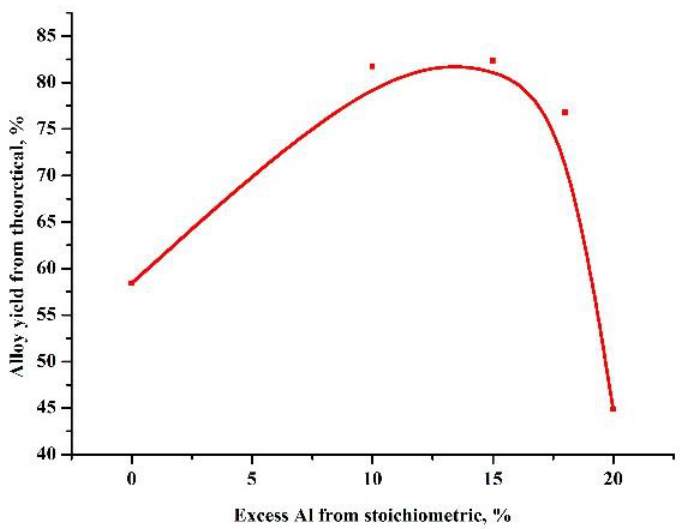
Figure 2. Dependence of the yield of the alloy on the excess of the oxidizer.